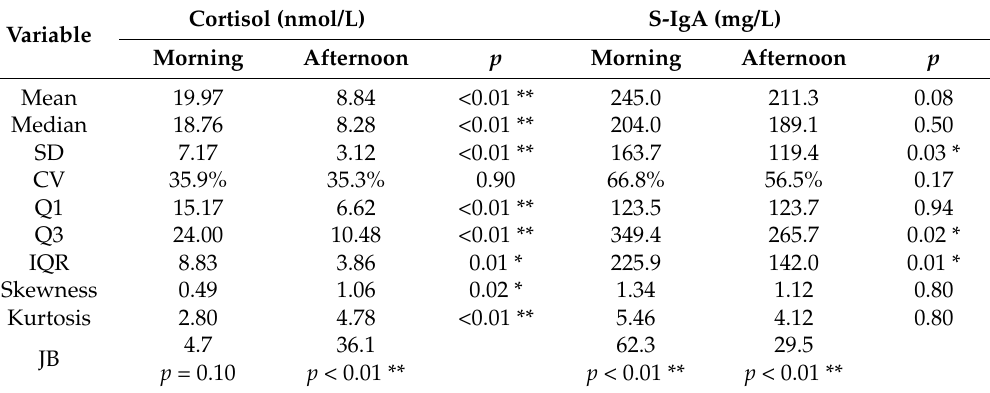
Table 2. Characteristics of the distribution of salivary cortisol and immunoglobulin A concentrations.